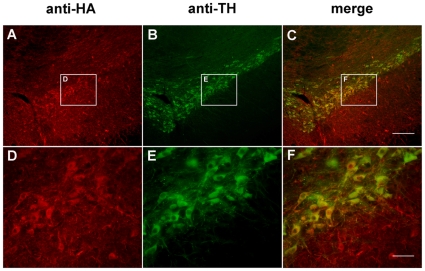
TAT-mediated internalization of fusion proteins into substantia nigra of rats.N-SYN was stereotactically injected in the substantia nigra of rats. After 24 hours, the nigral DA neurons were specifically labeled with anti-HA Ab (A, D) and anti-TH Ab (B, E). Detection with anti-HA Ab revealed the fusion protein localized in almost all cells in SNpc, including DA neurons (C, F, merge) in the injected hemisphere. No anti-HA staining was observed on the contralateral side (data not shown). SYN also localized in almost all cells in SNpc (data not shown). Scale bars: (A–C), 200 µm; (D-F), 50 µm.